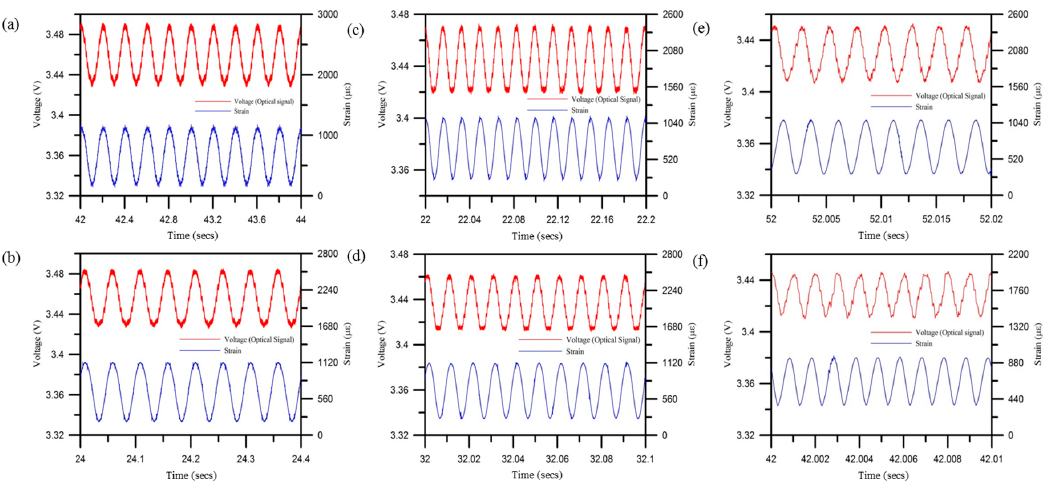
Figure 8. The dynamic voltage signals of the FBG interrogation system (the dip of the resonant wavelength of the WGM was 1535.10 nm) and the oscillating values of the strain gauge adhered on the PZT. The frequencies of the PZT were ( a ) 5 Hz; ( b ) 20 Hz; ( c ) 60 Hz; ( d ) 100 Hz; ( e ) 400 Hz; and ( f ) 1000 Hz, respectively. Table 1. The signal-to-noise ratio (SNR) of the fiber Bragg grating (FBG) interrogation system based on whispering gallery mode (WGM) edge filter. PZT: piezoelectric